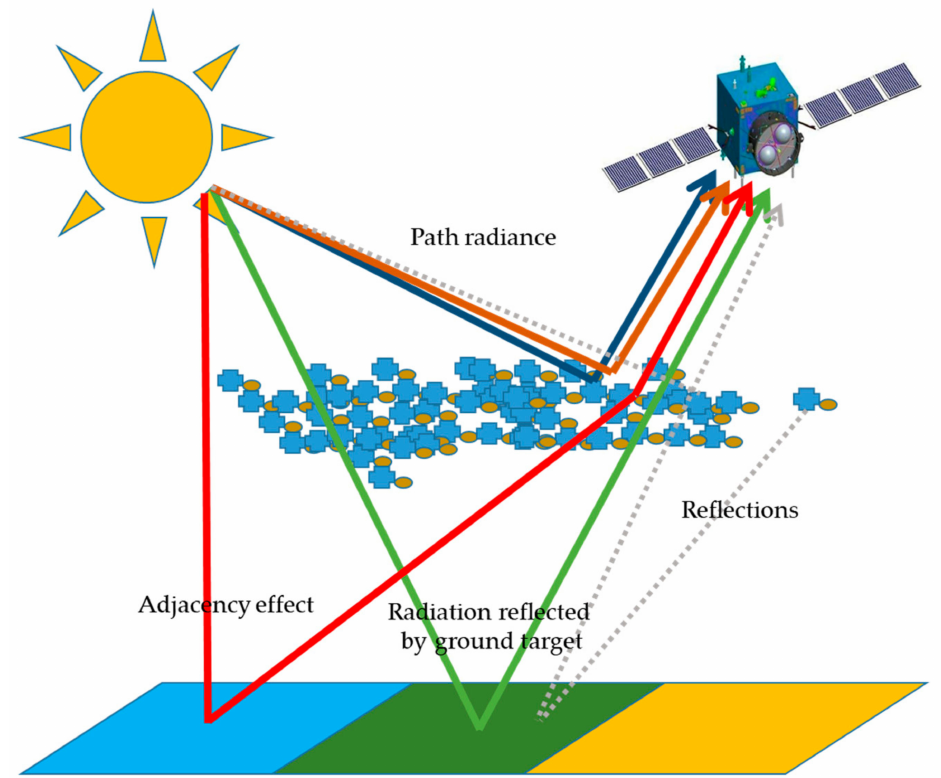
Figure 4. Main contributions to the received radiance of a single sensor